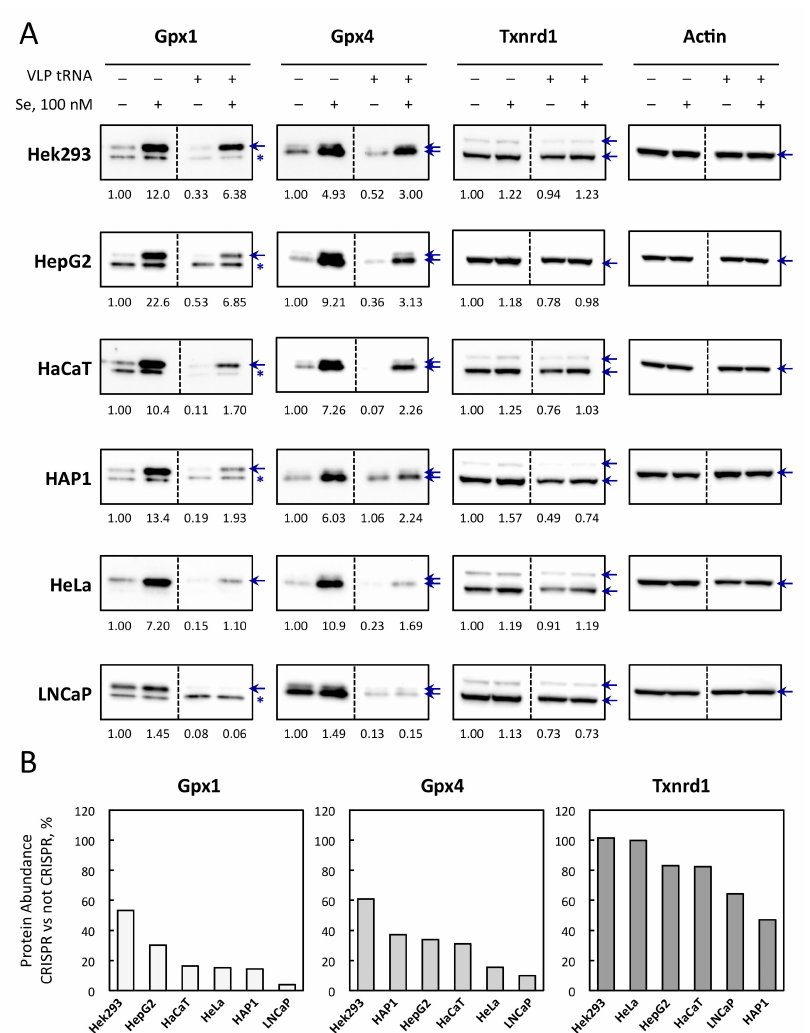
Figure 7. Evolution of Gpx1, Gpx4, and Txnrd1 protein levels in response to the VLP treatment and / or addition of selenium (100 nM) in various cell lines. ( A ) The six di ff erent cell lines were treated, or not, with 20 pmol of Cas9 tRNA VLPs and amplified for another four days with or without 100 nM Se in the culture medium. Protein extracts from the harvested cells were analyzed for selenoprotein levels by performing western blots with specific antibodies against Gpx1, Gpx4, Txnrd1 and Actin. The selenoproteins are indicated by blue arrows. According to the manufacturer, Gpx1 gives an non-specific band (indicated by an asterisk) below the correct one. Gpx4 has two isoforms, mitochondrial and cytoplasmic, respectively. Depending on cell lines, Txnrd1 has several isoforms. The quantifications were normalized to the intensity of the signal for actin and expressed relative to the non-VLP treated condition in control medium, set as 1. ( B ) The relative decrease of Gpx1, Gpx4, and Txnrd1 protein abundance in response to 20 pmol of Cas9 tRNA VLPs treatment and in presence of 100 nM Se was plotted for the six di ff erent cell